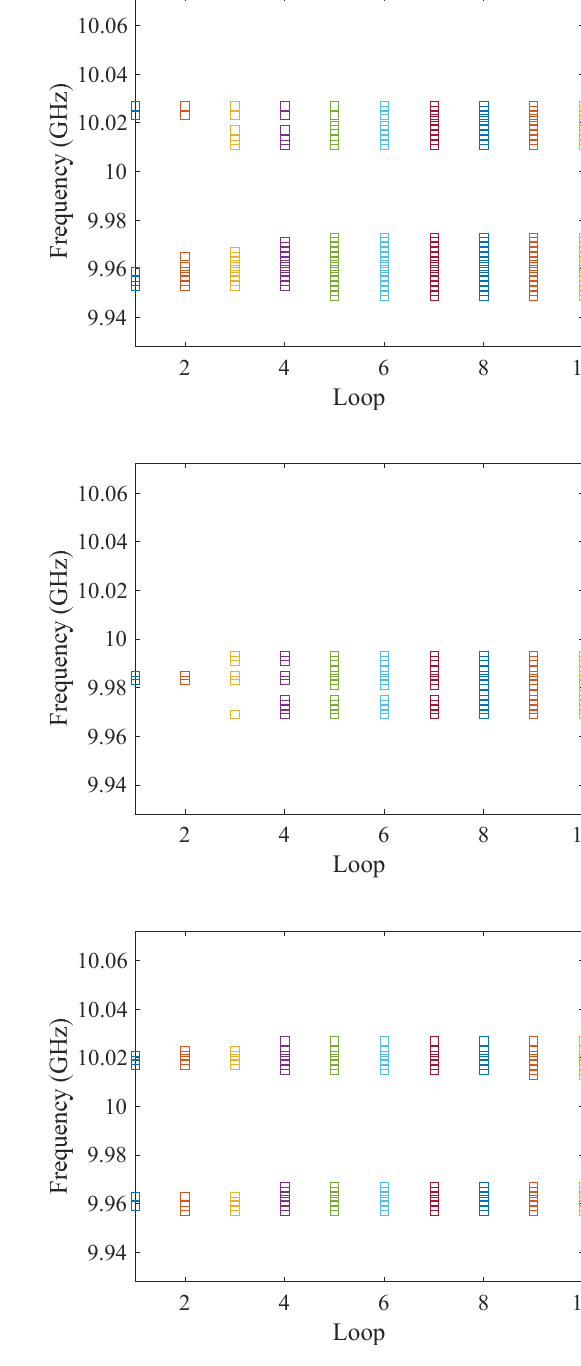
Figure 22. (Left) TFS diagrams of three WBIs with different parameters and (right) the corre- Figure 22. ( Left ) TFS diagrams of three WBIs with different parameters and ( right ) the corresponding WBI-interfered sub-pulse detection sponding WBI-interfered sub-pulse detection examples.